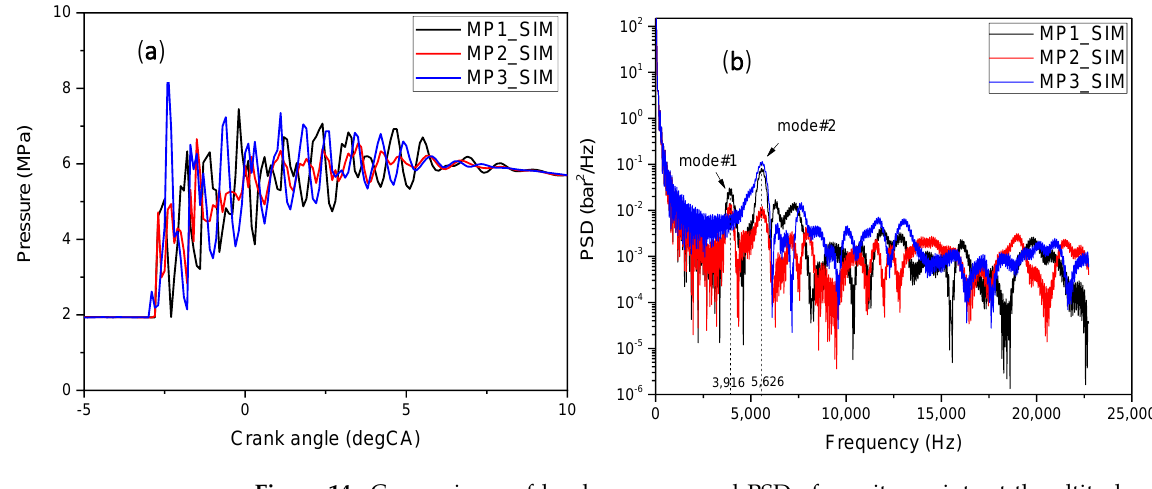
Figure 14. Comparisons of local pressures and PSD of monitor points at the altitude of 4.5 km: ( a ) comparison of local pressures of three monitor points; ( b ) comparison of PSD of three monitor points.